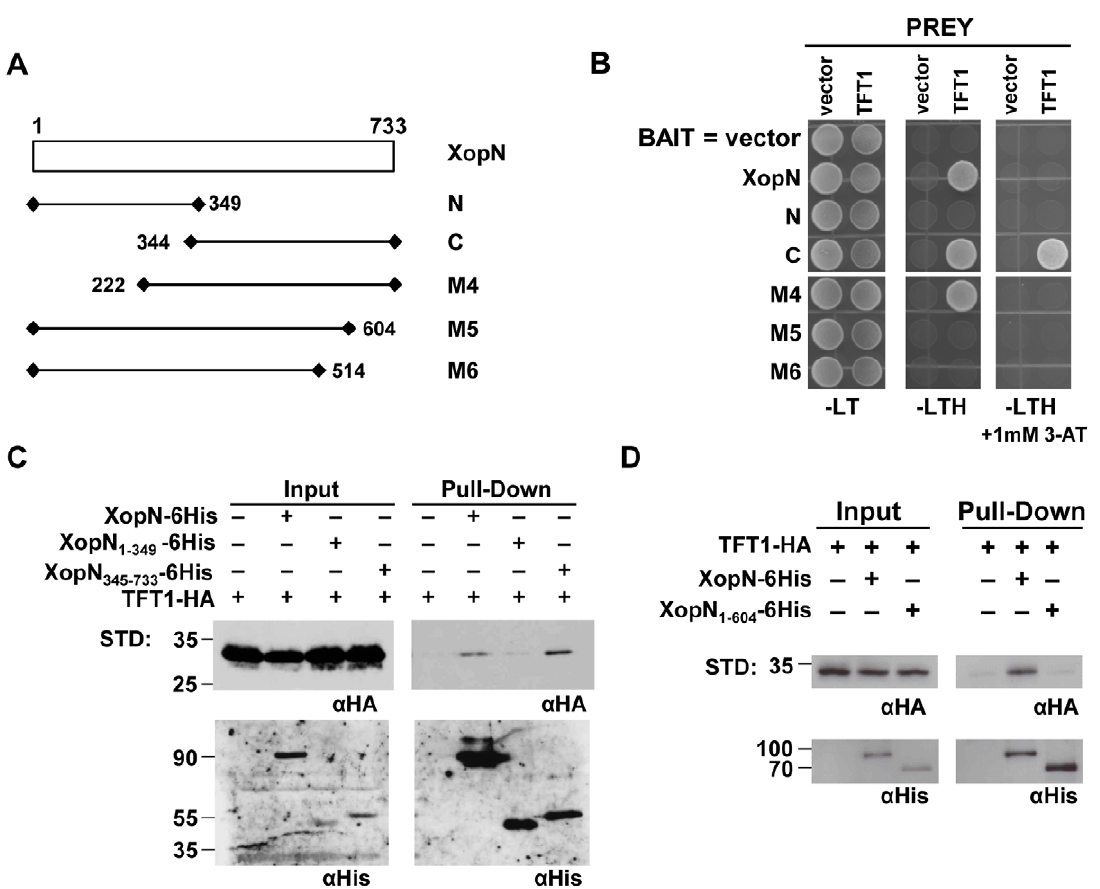
Figure 4. TFT1 associates with the C-terminal domain of XopN. ( A ) Schematic of XopN protein and various deletion mutants. Wild type and mutant xopN were cloned into pXDGATcy86(GAL4-DNA binding domain) to create DBD-XopN fusion proteins: XopN, XopN 1–733; N, 1–349; C,